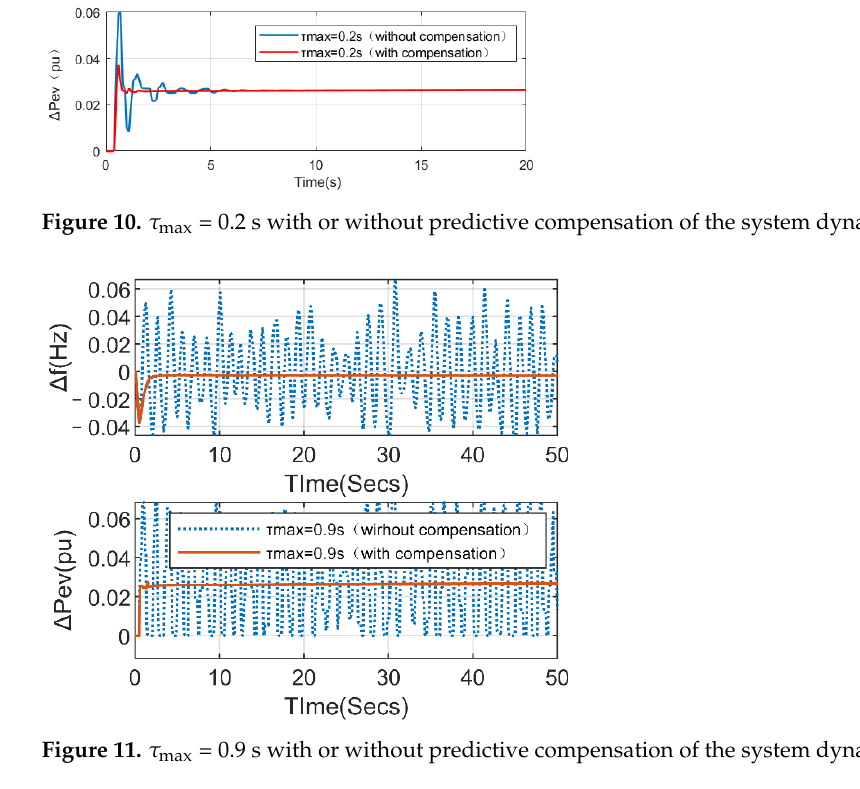
τ Figure 11. τ max = 0.9 s with or without predictive compensation of the system dynamic Figure 11. max = 0.9 s with or without predictive compensation of the system dynamic re- sponse.